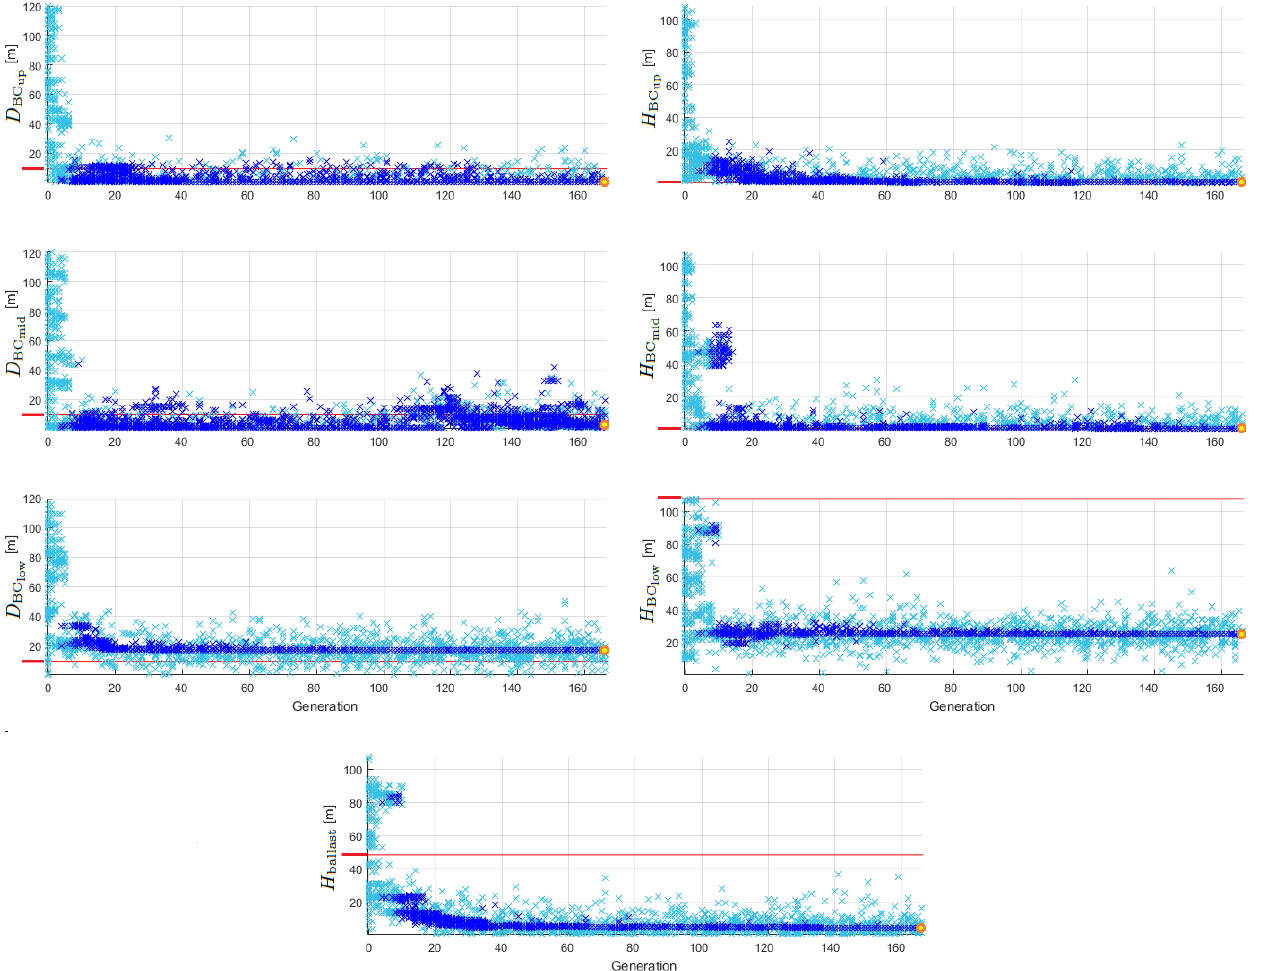
Figure 3. Development of the design variables within the iterative optimization process: all simulated individuals are represented by light blue crosses and those complying with all constraints by dark blue crosses, the best-performing individual is marked with a yellow filled circle framed in orange, and the value corresponding to the reference FOWT system is plotted as a red